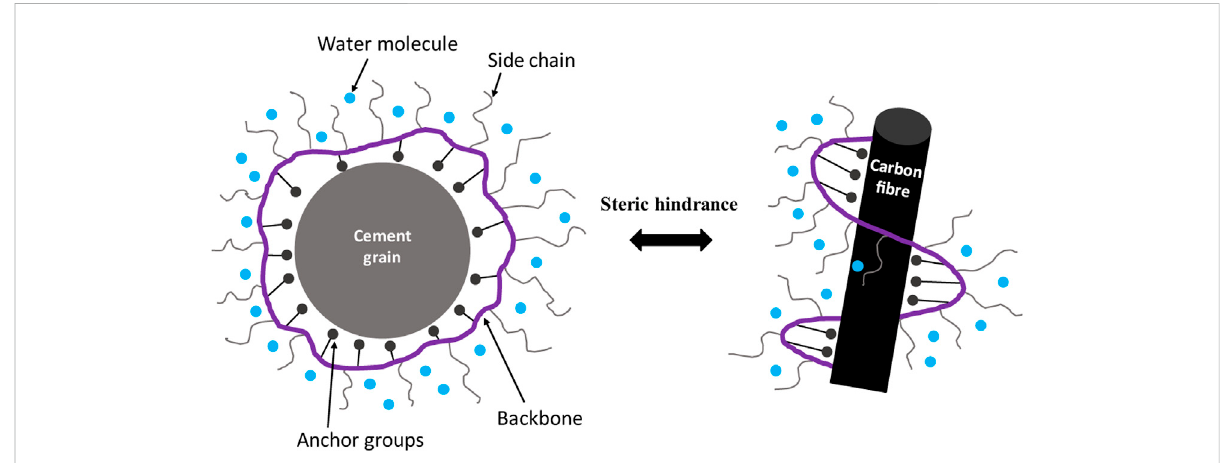
FIGURE 6 The “ double dispersion ” mechanism by polycarboxylate superplasticizer in the matrix of smart cement-based